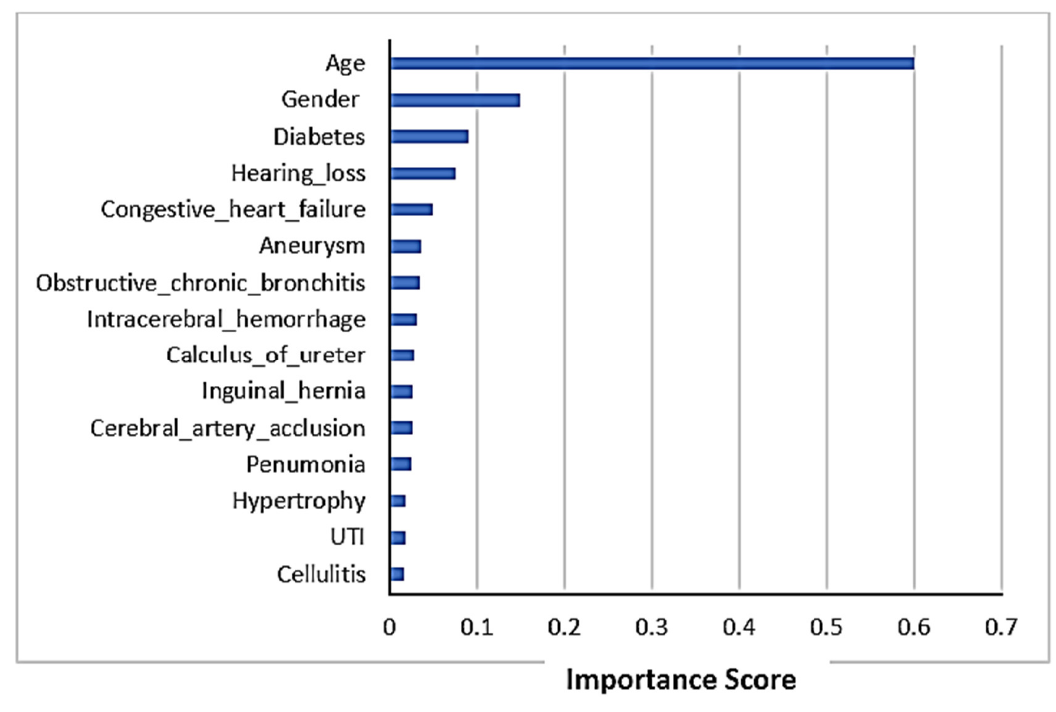
Figure 3. Feature importance scores in LoS prediction.